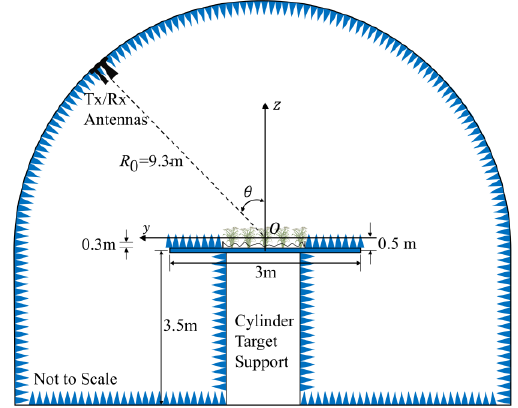
Figure 4. Rice field scene layout (front view).